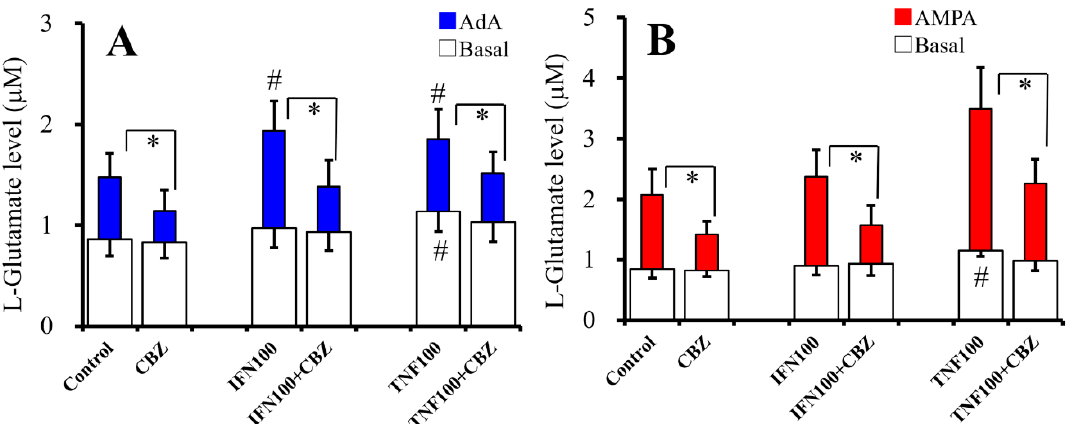
Figure 5. Interaction between chronic cytokines administration and acute CBZ administration on basal, AdA-, and AMPA-evoked releases of L-glutamate. Interaction between chronic cytokines (100 IU / mL IFN γ and TNF α ) administration and acute CBZ (20 µ M) administration on basal (opened) and 1 µ M AdA-evoked ( A , blue) L-glutamate release are indicated in Figure 5A. Interaction between chronic cytokines (100 IU / mL IFN γ and TNF α ) administration and acute CBZ (20 µ M) administration on basal (opened) and 100 µ M AMPA-evoked ( B , red) L-glutamate release are indicated in Figure 5B. Ordinates indicate mean levels of L-glutamate ( µ M) ( N = 6). * p < 0.05 relative to non-CBZ and # p < 0.05 relative to control by two-way ANOVA with Tukey’s post hoc